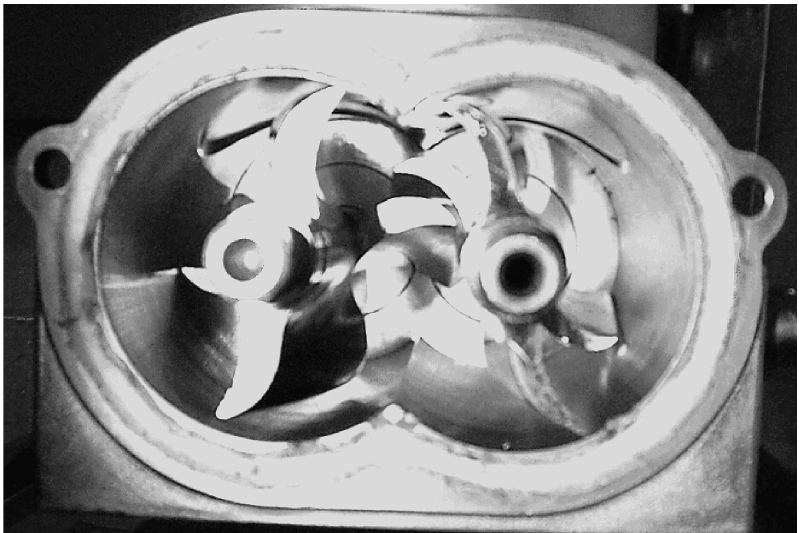
(Newtonian).Figure 1 (above): Mixing blades and chamber for Ika Kneader MKD